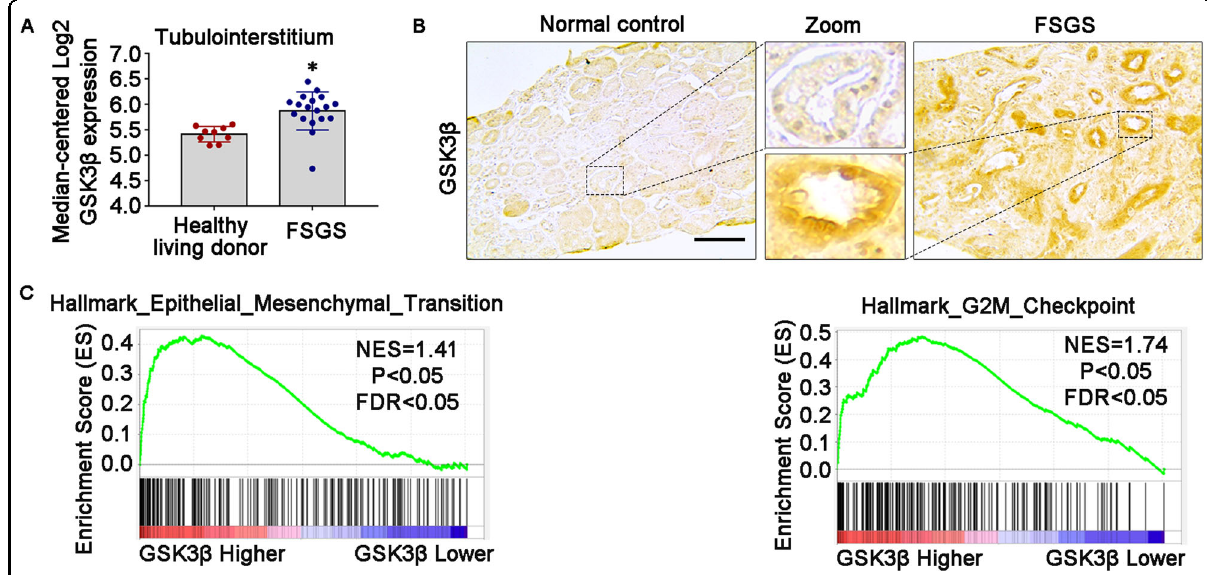
Fig. 1 Renal tubular overexpression of GSK3 β is involved in renal fi brogenesis in progressive CKD. A Post hoc bioinformatics analysis of renal tubulointerstitial transcriptome for the expression levels of GSK3 β mRNA in kidney tubulointerstitial specimens procured from healthy living donors and patients with FSGS. Renal tubulointerstitial transcriptome data were derived from www.Nephroseq.org on the basis of the ERCB nephrotic syndrome datasets. * P < 0.05 versus healthy living donor group ( n = 9 – 18). B Renal biopsy specimens from patients with FSGS and normal controls of pre-implant kidney biopsy specimens were processed for immunohistochemistry staining for GSK3 β . Representative micrographs were shown.